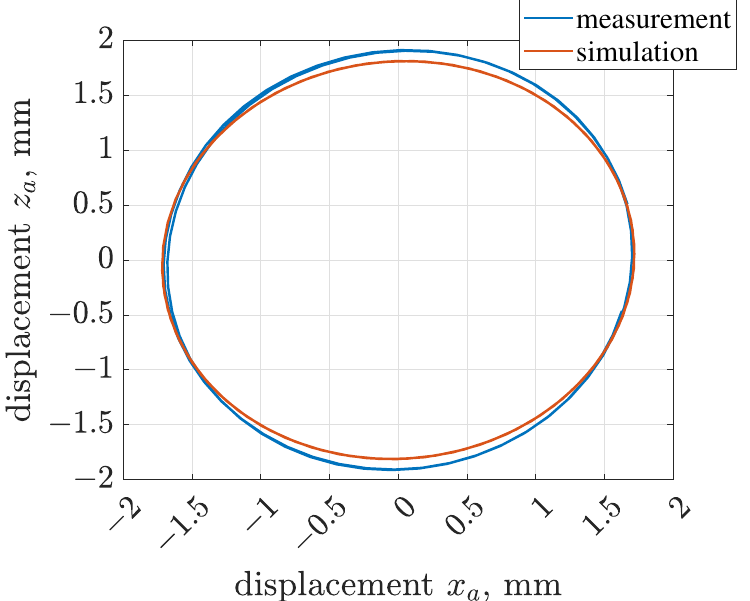
Figure 11. Comparison of trajectories of screen vibration displacement evaluated for measurement and simulation